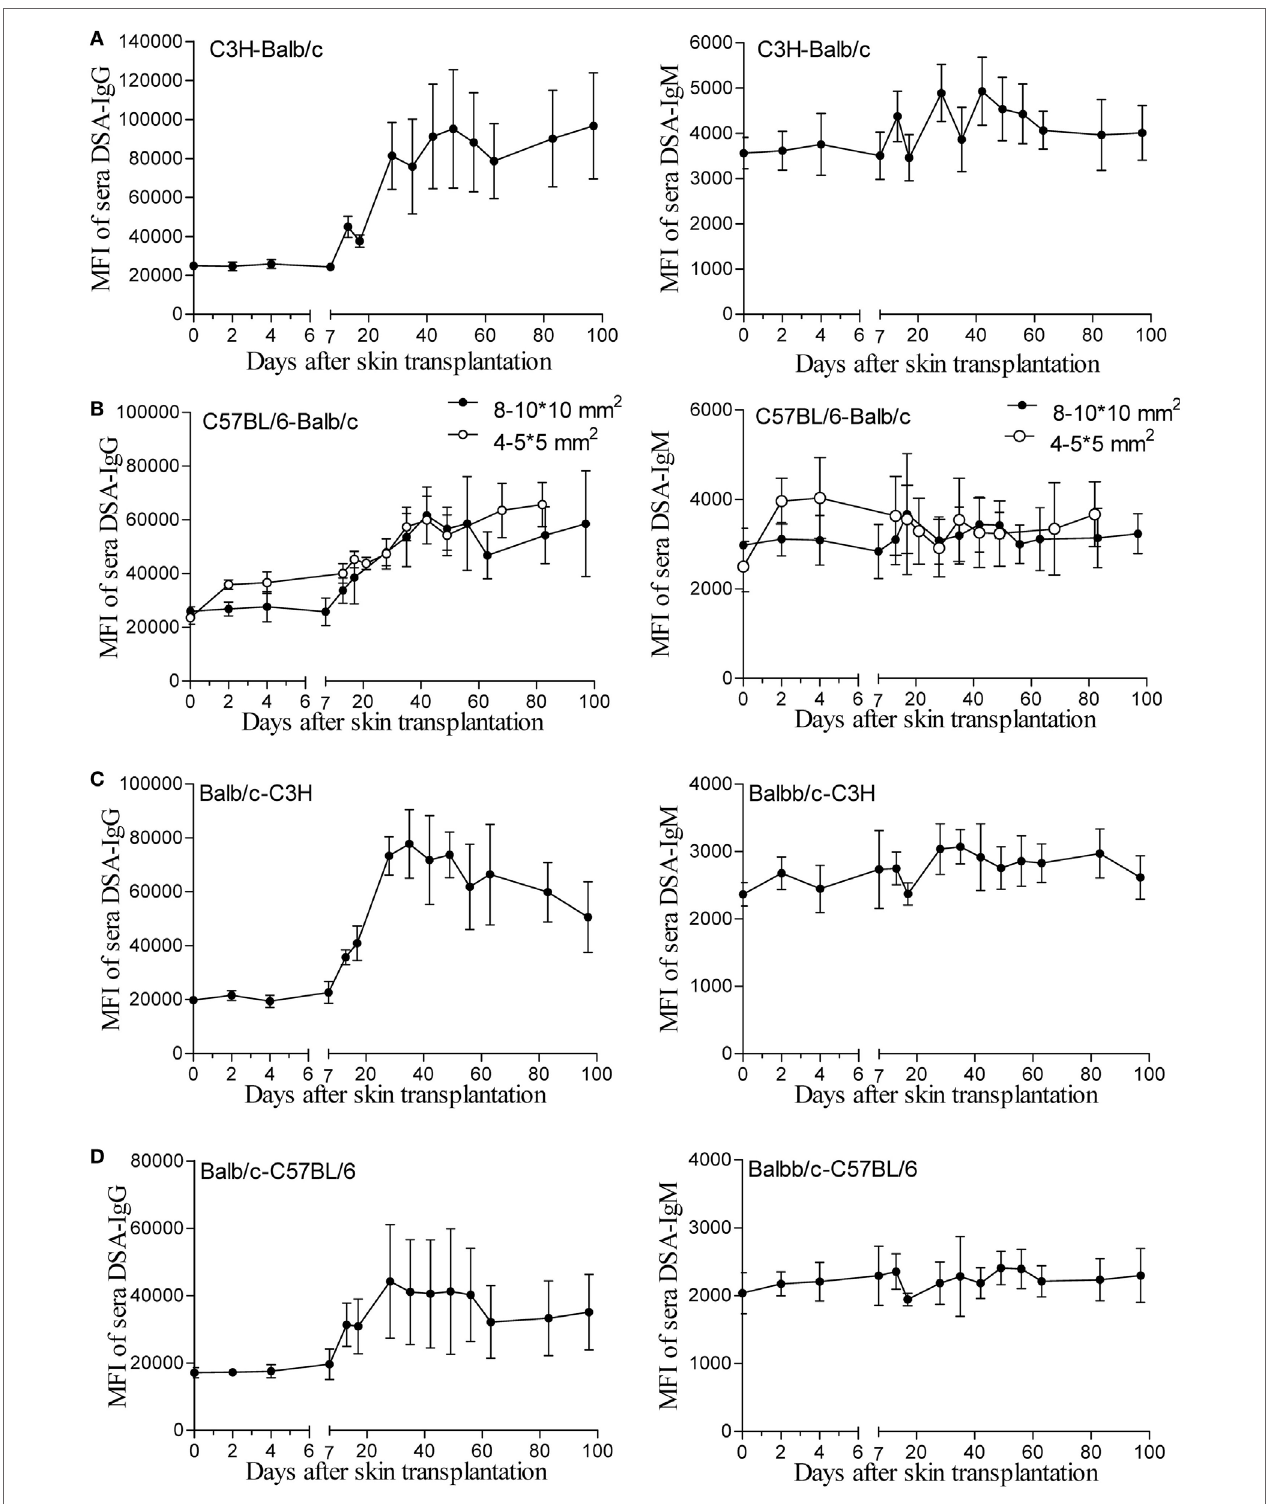
FigUre 1 | Donor-specific antibodies (DSAs) induced by skin graft sensitization were affected by donor-recipient combination and skin graft size and were sustained for a long time. Skin grafts of size 8–10 × 10 mm 2 were transplanted onto the back of recipient mice. Recipient sera collected at the indicated time points were reacted with donor spleen cells and evaluated by immunofluorescence and flow cytometry. Levels of detected IgG and IgM antibodies are expressed as mean fluorescence intensity (MFI) ± SD ( n = 6). (a) C3H-Balb/c. (b) C57BL/6-Balb/c, skin grafts of size 4–5 × 5 mm 2 were also applied for comparison with the grafts measuring 8–10 × 10 mm 2 . (c) Balb/c-C3H. (D) Balb/c-C57BL/6.